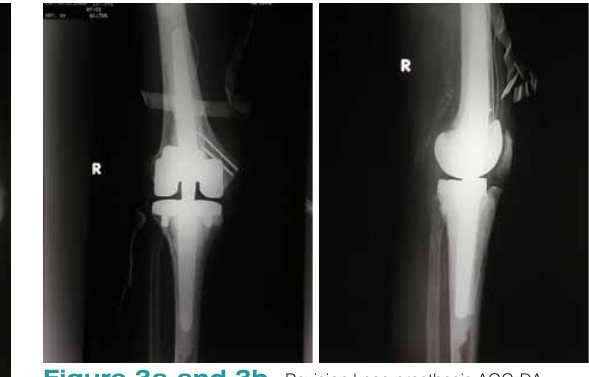
Figure 3a and 3b. Revision knee prosthesis AGC-DA implanted with cement loaded with 5% of vancomycin. Two Kirschner wires stabilising cortical bone of medial femoral condyle are